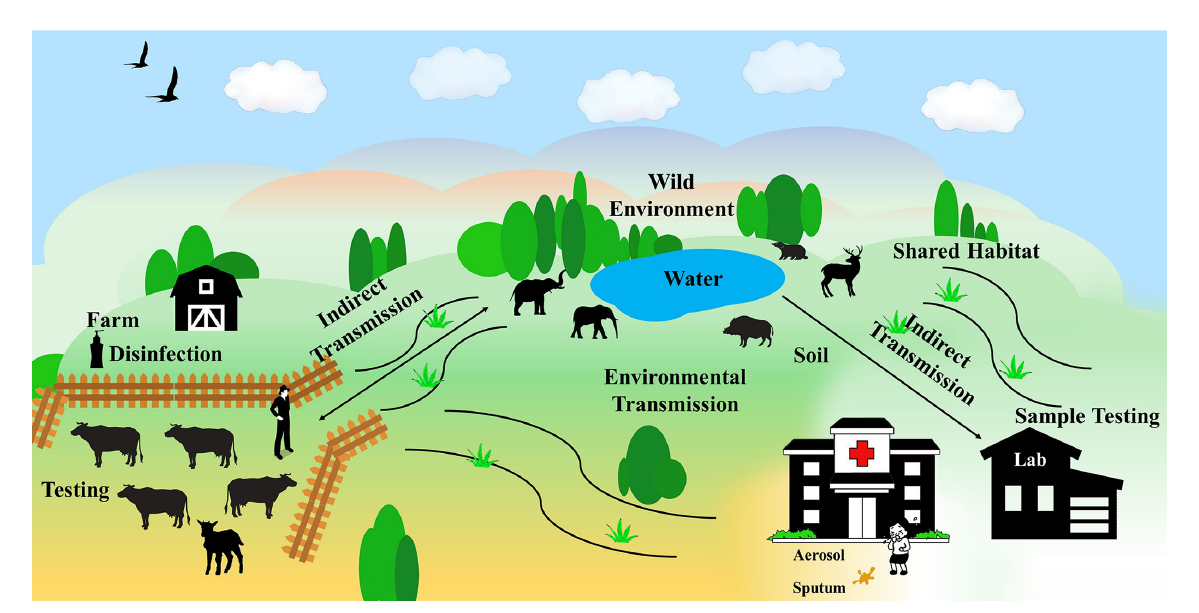
FIGURE1 The spread of MTBC in the environment. MTBC spreads among farms, wild environment, and human habitats, causing tuberculosis infection in humans and